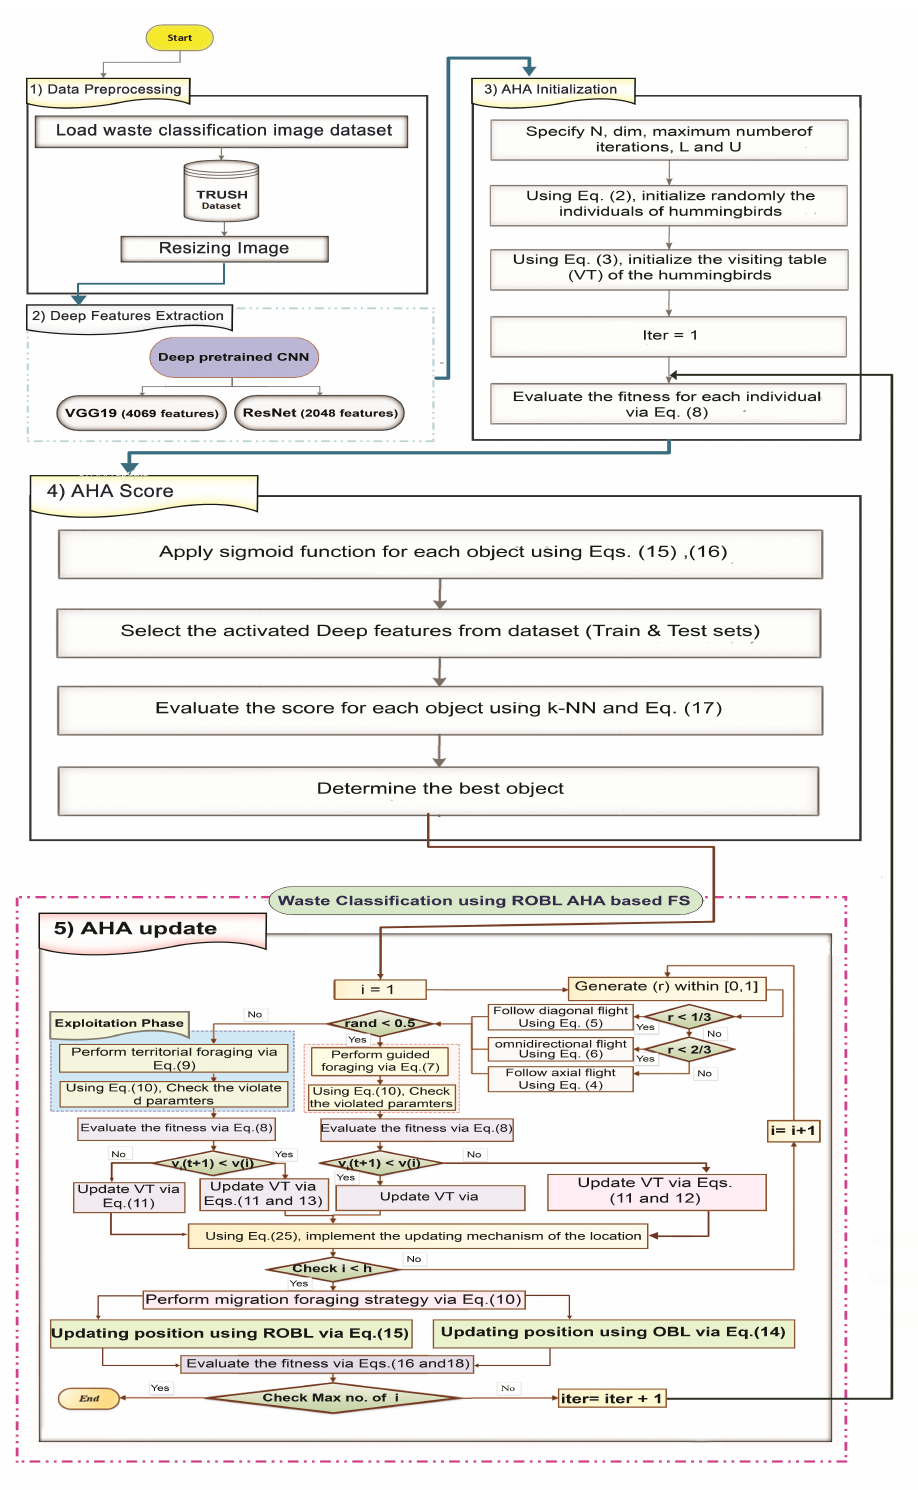
Figure 1. The design framework of the AHA-ROBL based on FS for waste